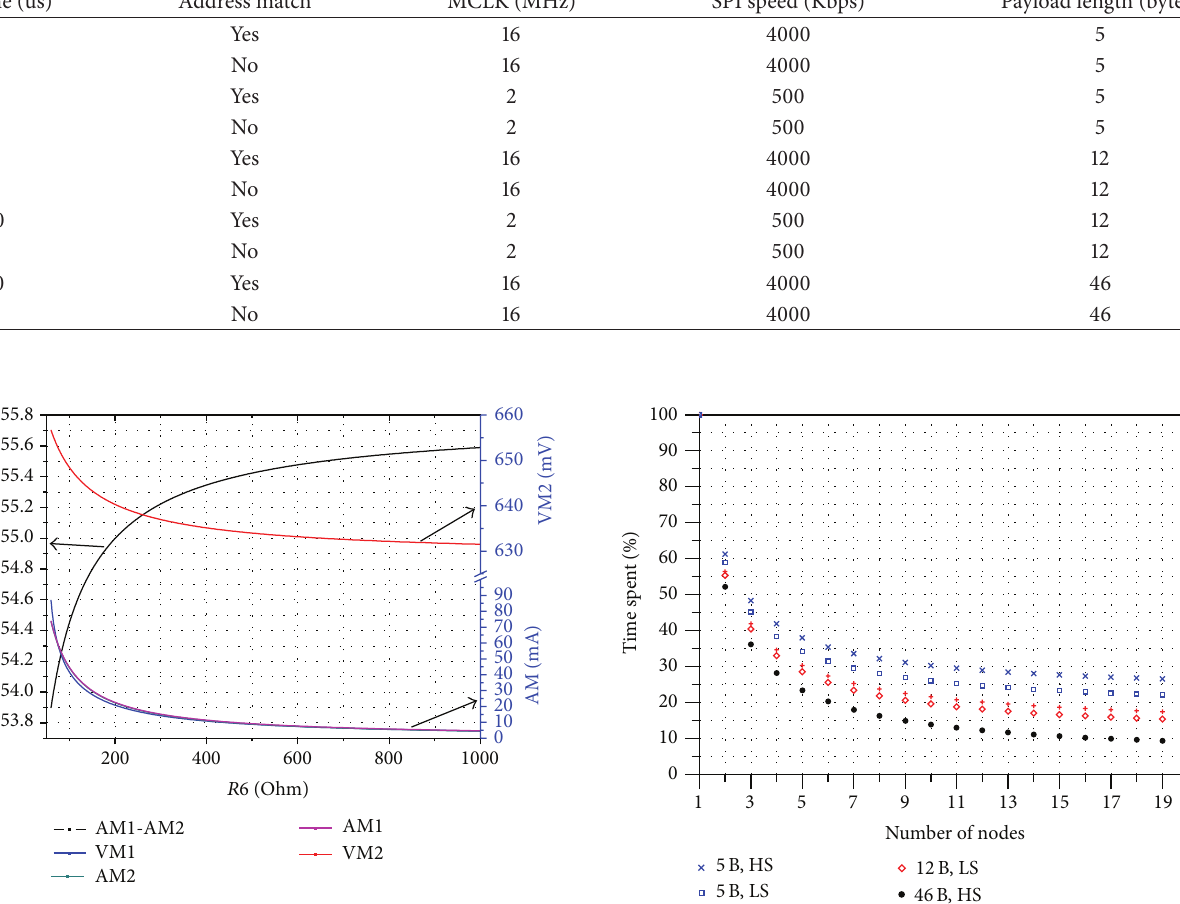
Figure 10: Voltages and currents versus loads.